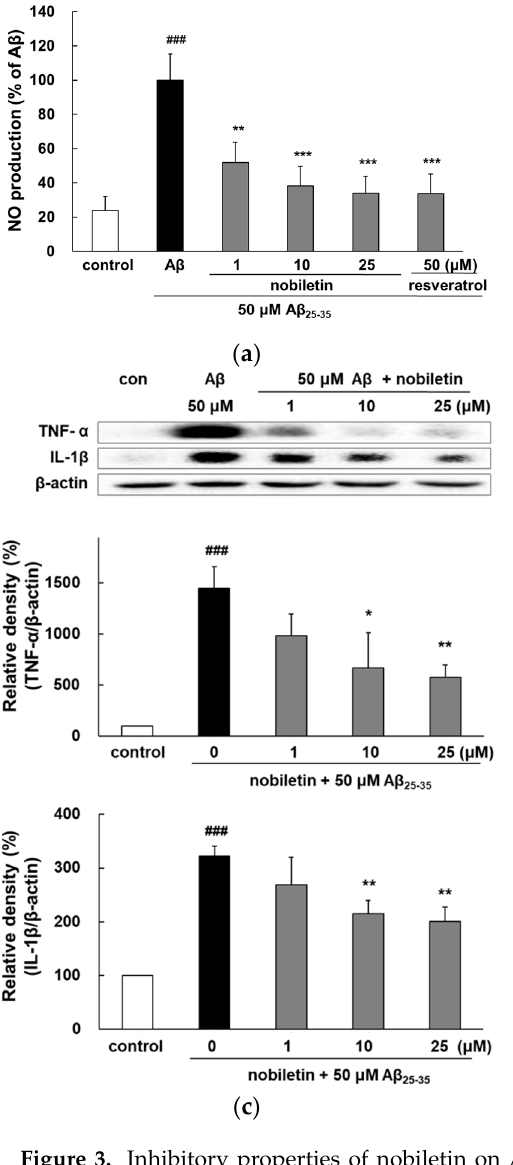
Figure 3. Inhibitory properties of nobiletin on A β 25-35 -mediated expression of ( a ) NO, ( b ) PGE 2 , ( c ) TNF- α and IL- β , and ( d ) iNOS and COX-2 in PC12 cells. The cells were pretreated with nobiletin for 1 h and then exposed to A β 25-35 for 24 h. The culture supernatant was collected to evaluate the NO and PGE 2 formation. Protein expression of TNF- α , IL- β , iNOS, and COX-2 was measured by Western blot analysis. The band intensities were quantified using Image J software and normalized to β -actin. ### p < 0.001 vs. control. *** p < 0.001, ** p < 0.01, and * p < 0.05 vs. A β 25–35 .